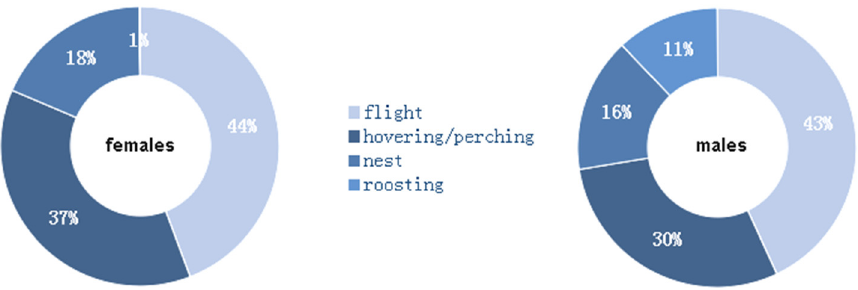
Figure 4. Ethograms of the tracked red-footed falcons for (left) females and (right) males. In the daytime, the red-footed falcons spent 51% of the time in flight, while hovering or perching activity accounted for 34% of the time (Figure 5). In the night-time, flight activity was one-third of that in the daytime, while roosting increased by up to 39%